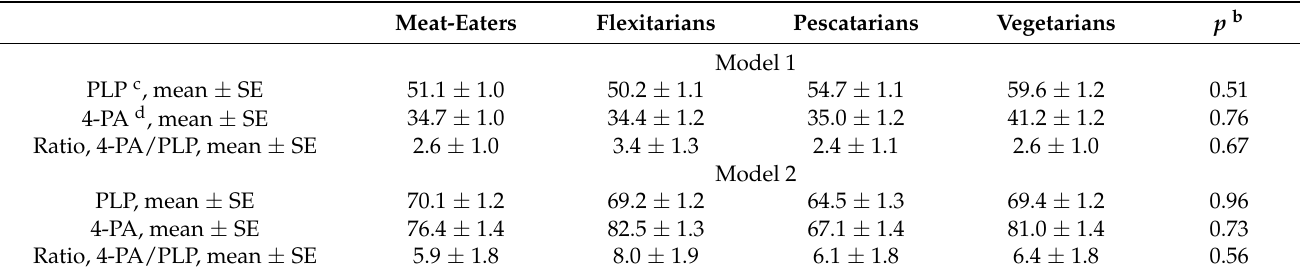
Table A3. Adjusted geometric mean vitamin B6 vitamer serum concentrations of study participants following a meat-eating, flexitarian, pescatarian or vegetarian diet a .